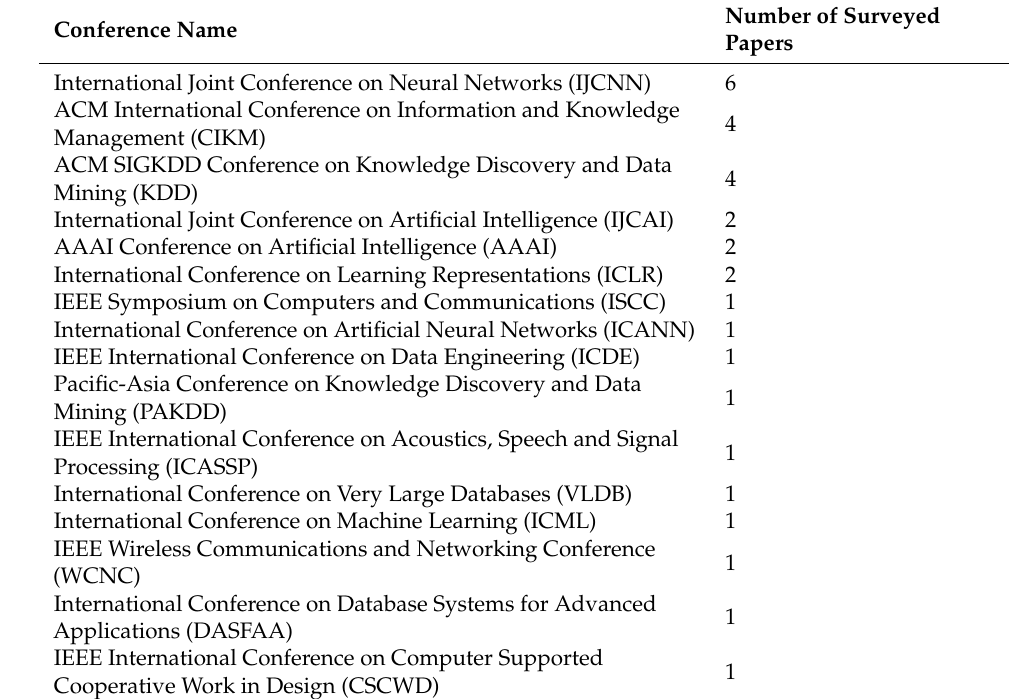
Table A3. The source conferences for the surveyed